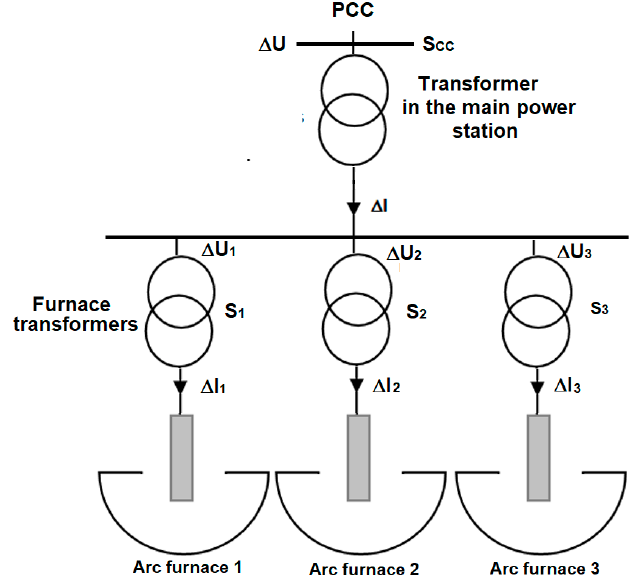
Figure 14. Power supply scheme for parallel working arc furnaces.